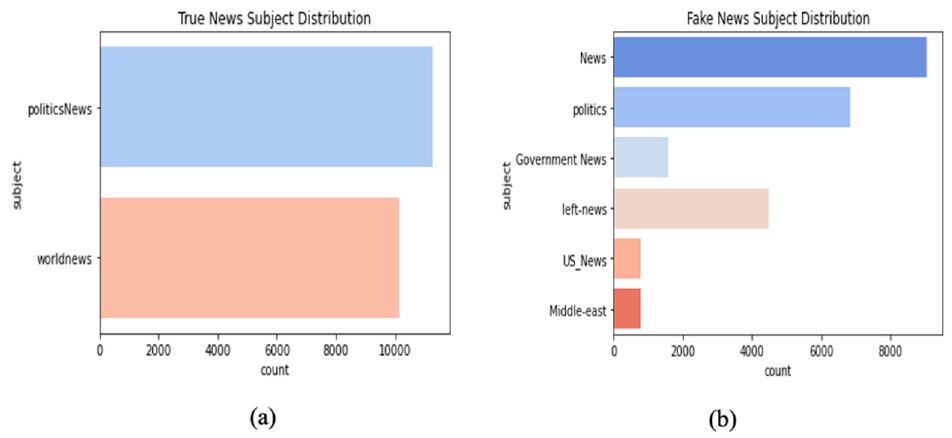
Figure 2. ( a ) True News subject distribution ( b ) Fake News subject distribution.